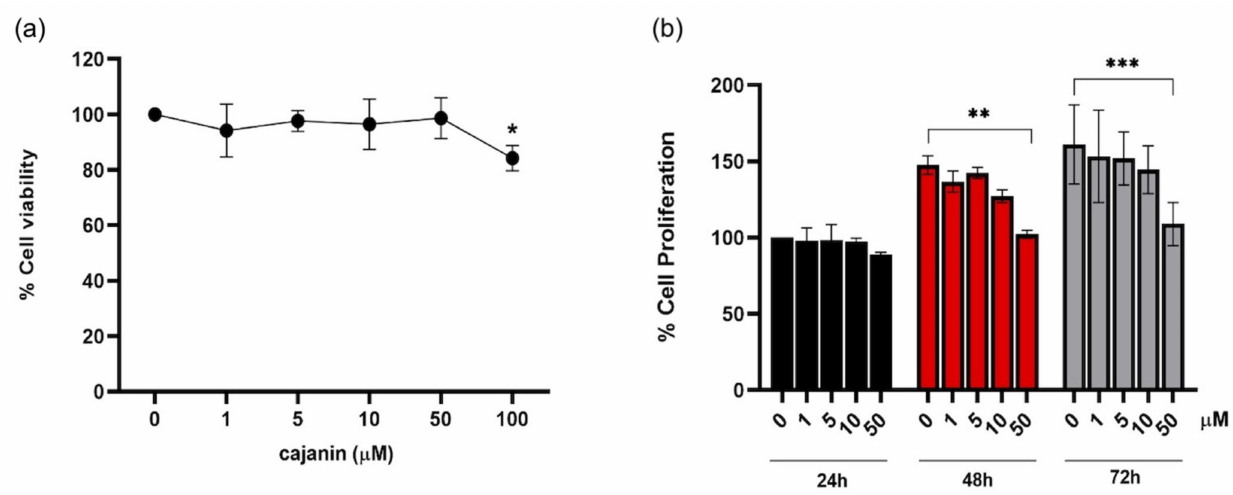
Figure 2. Cytotoxic profile of cajanin in human melanin-producing cells. ( a ) The significant reduction of %cell viability determined by MTT assay was noted in human melanoma MNT1 cells treated with 100 µ M cajanin for 72 h. Although there was no alteration of viability observed with the lower concentrations (1–50 µ M), ( b ) the incubation with 50 µ M cajanin for 48–72 h obviously suppressed proliferation in MNT1 cells. Experiments were performed in triplicate and data are expressed as mean ± SEM. * p < 0.05, ** p < 0.01, *** p < 0.005 versus non-treated